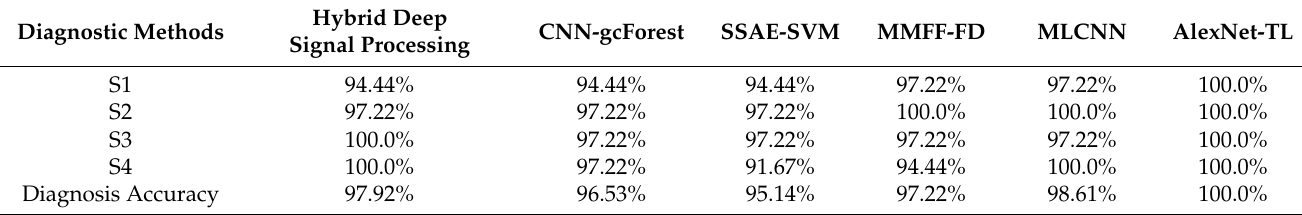
Table 9. Diagnostic results of different fault diagnosis